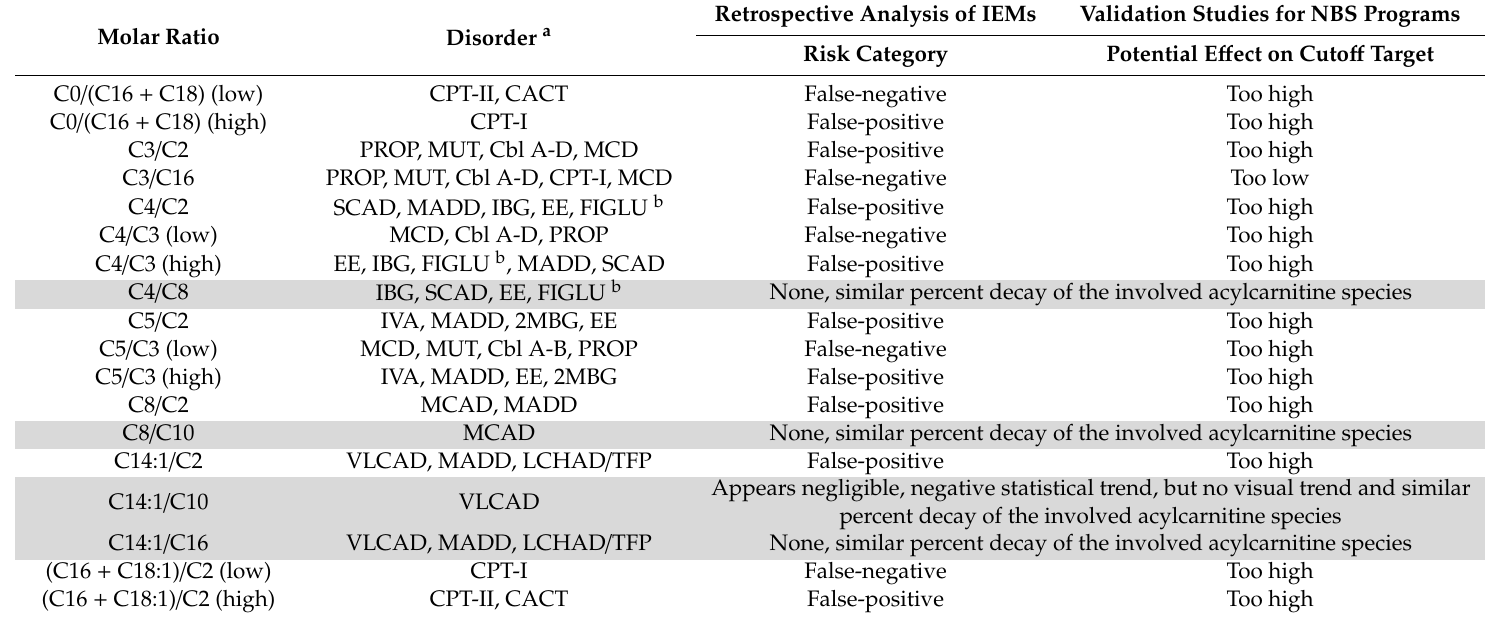
Table 2. Potential impact of metabolite instability on the interpretation of carnitine and acylcarnitine